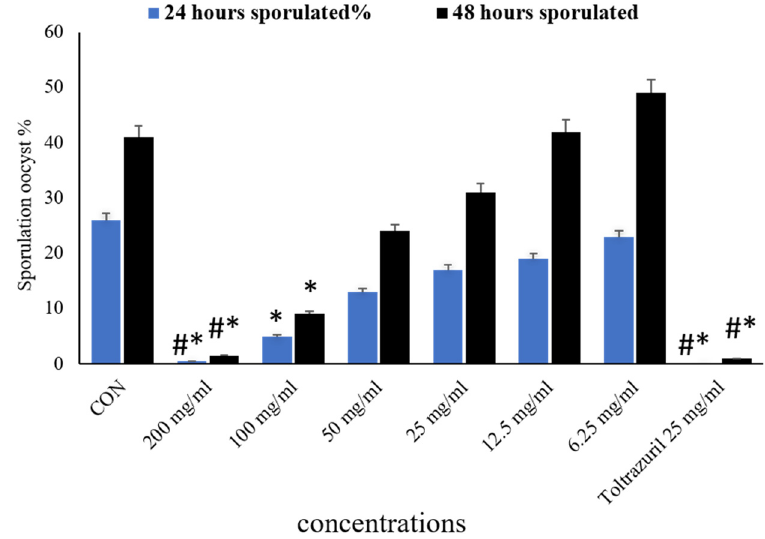
Figure 2: E ff ects of CPLE on oocysts sporulated of E. papillata of concentration at 24 and 48 h in vitro ; CON, control. The signi fi cance was compared to potassium dichromate 2.5% as a negative control and Toltrazuril 25 mg/mL as a positive control. ( *# ) : p - value ≤ 0.001 and ( * ) : p - value ≤